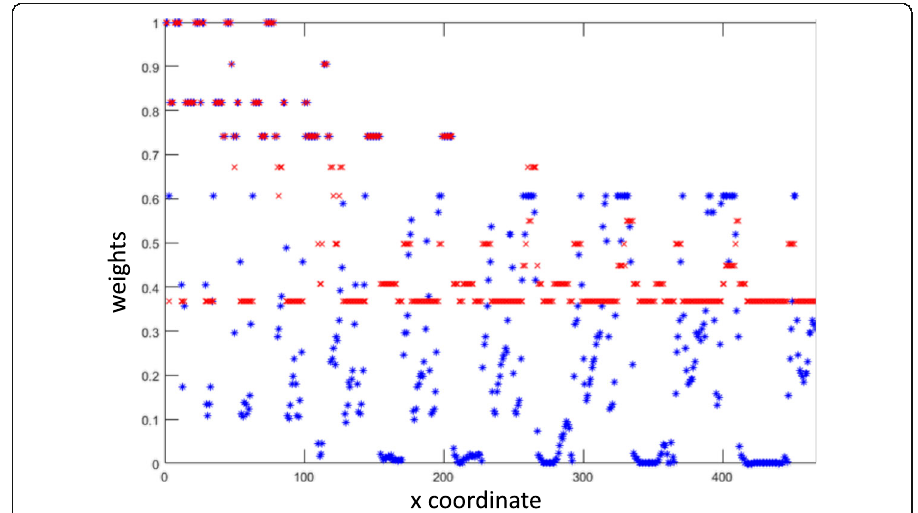
Fig. 9 Variations of the SLIC-only and the proposed adaptive aggregation